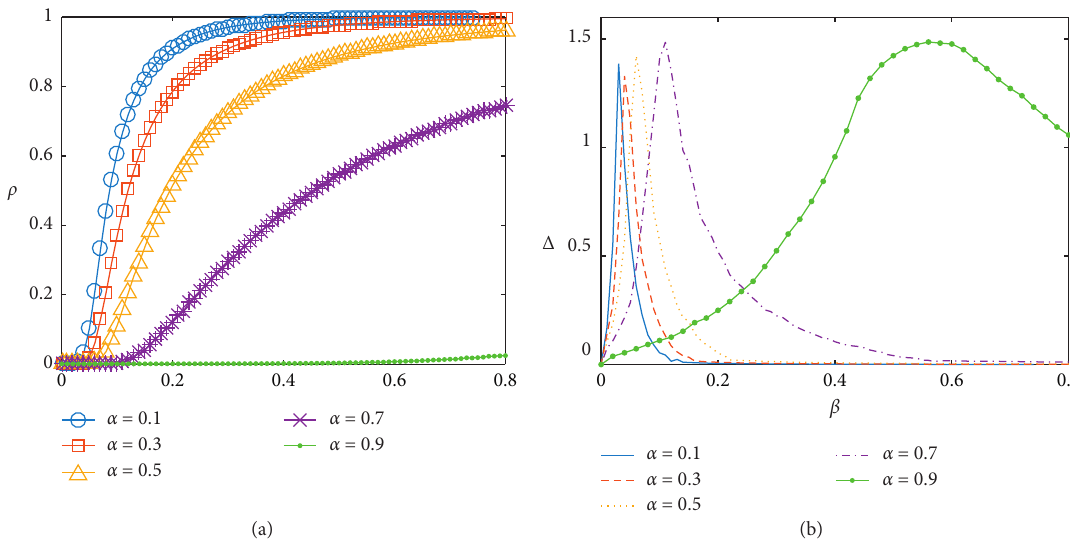
Figure 1: Effects of awareness-driven individual resource allocation on the spreading dynamics in scale-free networks. (a) The final infected density ρ as a function of basic transmission rate β for five typical values of instinctive self-awareness α . (b) Plots of variability measure Δ vs. β . The other parameters are set to be δ � 0 . 5, η � 0 . 001, ε � 0 . 6, μ � 0 . 1, and q 10 2 × 10 2 independent realizations on 10 2